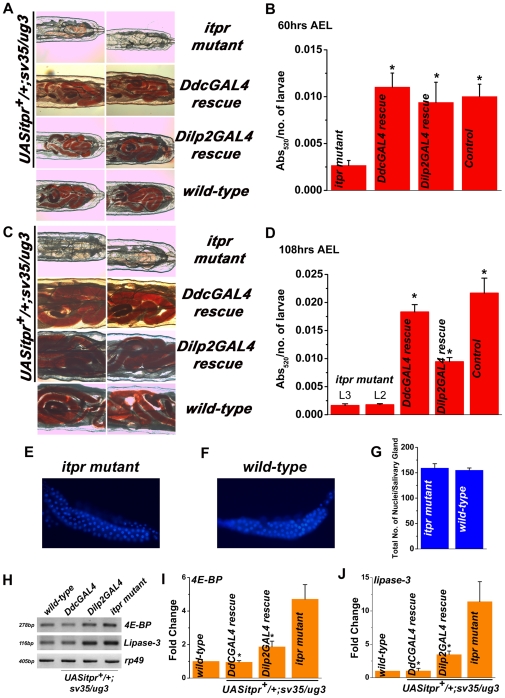
Feeding defects in itprsv35/ug3 can be rescued by UASitpr+ expression in Dilp2GAL4 and DdcGAL4 domains.(A, C) At 60 hrs and 108 hrs AEL, itprsv35/ug3 have much less red food in their guts in comparison to UASitpr+/+;DdcGAL4/+;itprsv35/ug3, UASitpr+/+;Dilp2GAL4/+; itprsv35/ug3 and wild-type larvae. (B, D) Spectrophotometric quantification of homogenates from larvae fed yeast paste containing a red dye. Control, Dilp2GAL4 or DdcGAL4 rescued larvae ingest significantly more dye than itprsv35/ug3 (itpr mutant) larvae at 60 hrs AEL (*p<0.05; Student's t-test) and at 108 hrs AEL (*p<0.005; Student's t-test). The following number of larvae (n) in batches (N) were assayed for each genotype: At 60 hrs AEL: n = 95 or more, N = 4 for all genotypes; at 108 hrs AEL: for UASitpr+/+;itprsv35/
ug3 L3 n = 46, N = 3; L2 n = 87, N = 3; for all other genotypes n = 100, N = 4 or more. Quantification of cell number in salivary glands from larvae at 60 hrs AEL stained with DAPI to visualize nuclei. itprsv35/ug3 (itpr mutant) in (E) and wild-type are shown in (F). No significant difference (G) was observed in the number of nuclei in itpr mutant and wild-type salivary glands. n = 10 salivary glands for each genotype. RT-PCR analysis (H) and quantitative real-time PCR analysis (I, J) revealed significant up-regulation of transcript levels of d4E-BP and dLipase-3 in itprsv35/ug3 at 60 hrs AEL that can be significantly rescued by Dilp2GAL4 or DdcGAL4 driven expression of UASitpr+ (*p<0.005; Student's t-test). Real-time PCR analysis was repeated three times with independently isolated RNA samples for each genotype. Results are expressed as mean±SEM.